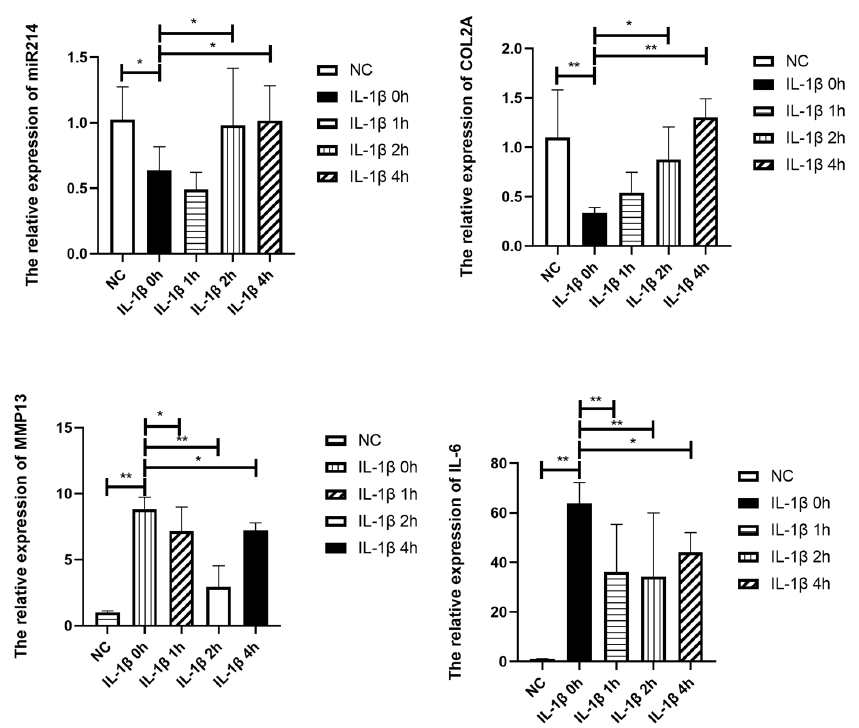
Figure 8. RNA expression of metabolic, inflammatory factors and miR-214 of chondrocyte. NC: Control group, IL-1 β 0 h: IL-1 β + 0 h strain, IL-1 β 1 h: IL-1 β + 1 h strain, IL-1 β 1 h: IL-1 β + 1 h strain, IL-1 β 2 h: IL-1 β + 2 h strain, IL-1 β 4 h: IL-1 β + 4 h strain (n = 4, * p < 0.05, ** p <